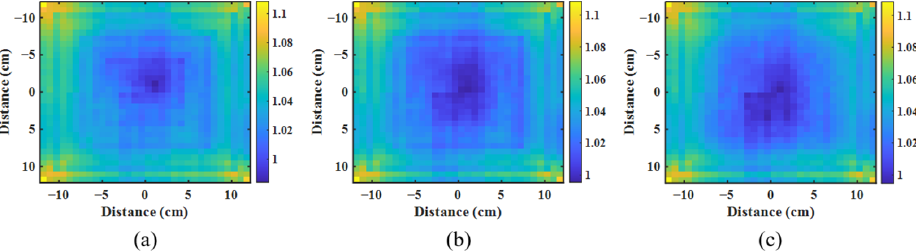
Figure 3. EPID correction matrices of backscatter and off ‐ axis response. ( a ), ( b ) and ( c ) are correction matrices composed of 9–24 cm 2 , 13–24 cm 2 and 18–24 cm 2 fields respectively.